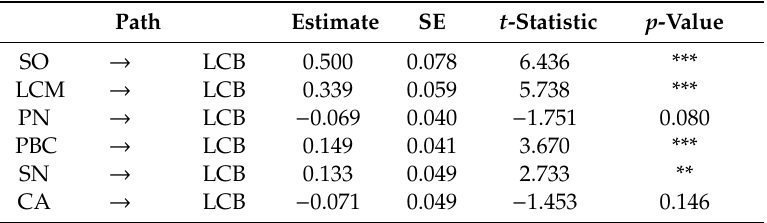
Table 10. Regression weights in the initial model (M1).